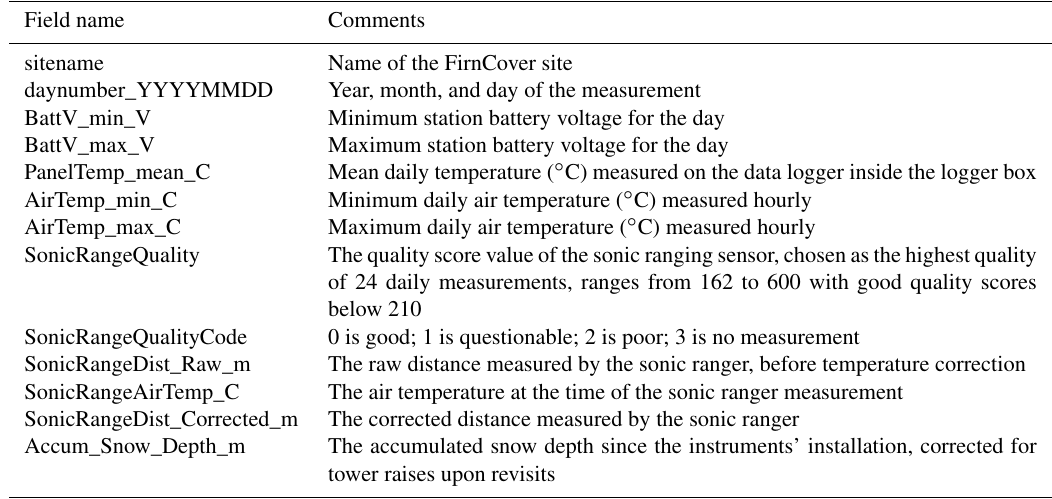
Table A3. Meteorological_Daily table.